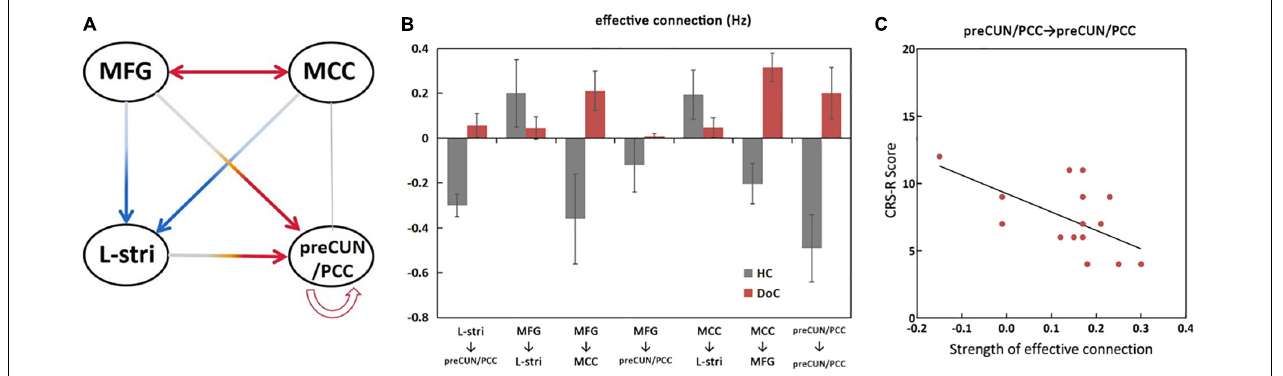
FIGURE 6 | Significant changes in effective connections (Hz) in the DOC patients. Red arrows, connections with significant increases; blue arrows, connections with significant decreases ( P < 0.05) (A) . Mean effective connections of significantly changed pairs of regions (B) . The strength of self-connection of preCUN/PCC is negatively correlated with the score of CRS-R (C) . L, left; R, right; Stria, striatum; preCUN, precuneus; PCC, posterior cingulate cortex; MCC, middle cingulate cortex; MFG, middle frontal